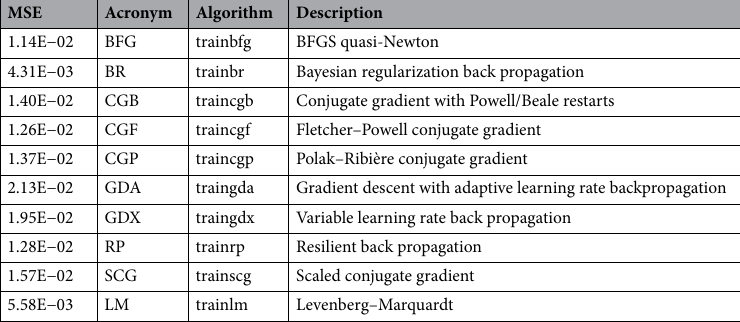
Table 3. Error value comparison of various training methods in MATLAB software.